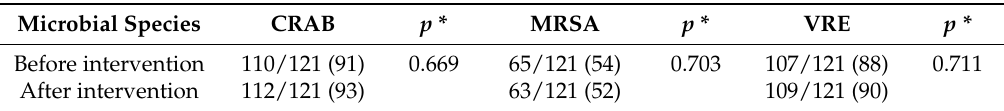
Table 5. Pass rate of all sampling sites determined by the absence of CRAB, MRSA and VRE before and after the